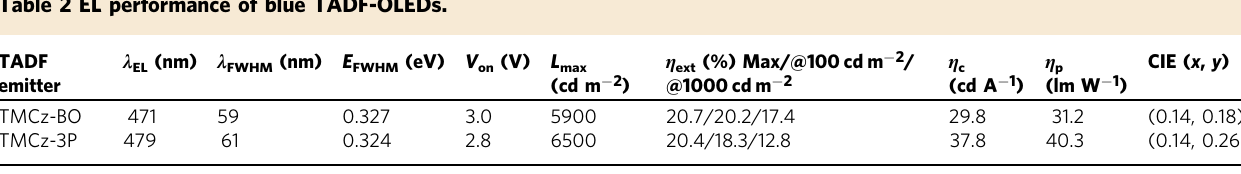
Fig. 4 PL spectra at room temperature and 77 K. a , b Fluorescence (line, 298 K) and phosphorescence (dash dot, 77 K) spectra of doped fi lms for a TMCz- BO and b TMCz-3P . c Arrhenius plots of rate constants of RISC ( k RISC ) obtained with the doped fi lms of 30 wt% TMCz-BO and TMCz-3P . Table 2 EL performance of blue TADF-OLEDs.